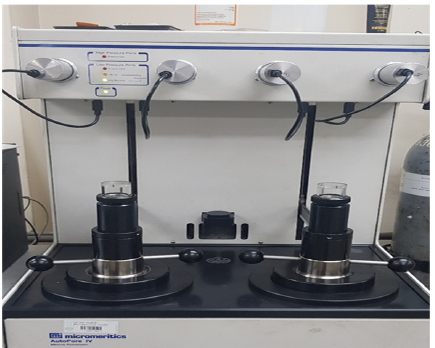
Figure 6. Mercury intrusion porosimetry (MIP) test setup.